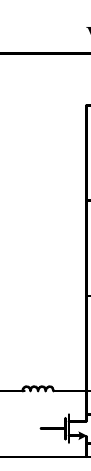
Figure 22. A single inductor buck-boost PV string equalizer [48].